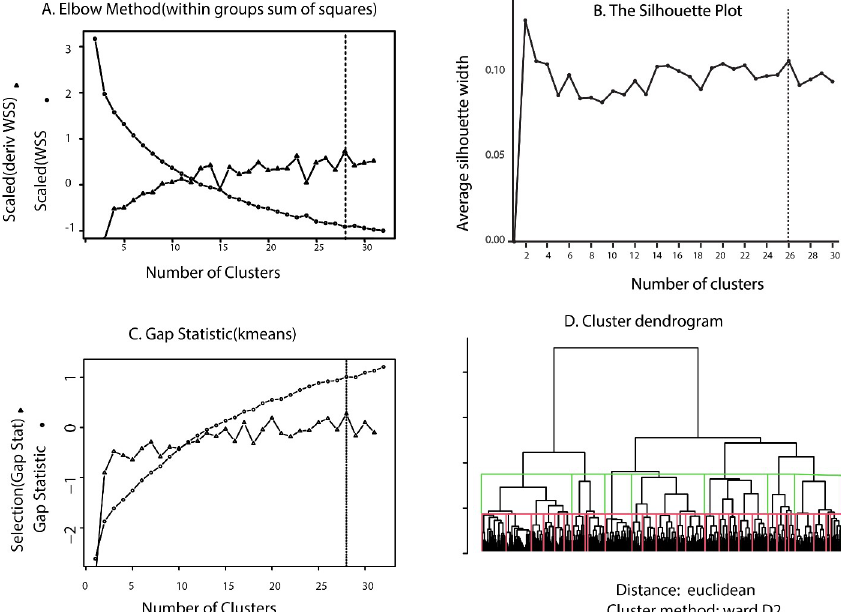
Fig 1. Results for selecting optimal cluster size using the elbow method (Panel A), silhouette method (Panel B) and the gap_statistic method (Panel C). Selection for the elbow method is based on the largest local derivative of the within groups sum of squares ( Panel A triangles), the maximum silhouette width ( Panel B ) and the first non-negative value for Gap(k)-(Gap(k + 1) − sd k+1 ) ( Panel C triangles). These results indicate an optimal number of clusters in the 26–28 range. Panel D displays the GI50 codebook dendrogram (Euclidean, Ward’s) with cuts at 28 (red lines) and 7 clusters (green lines), respectively.